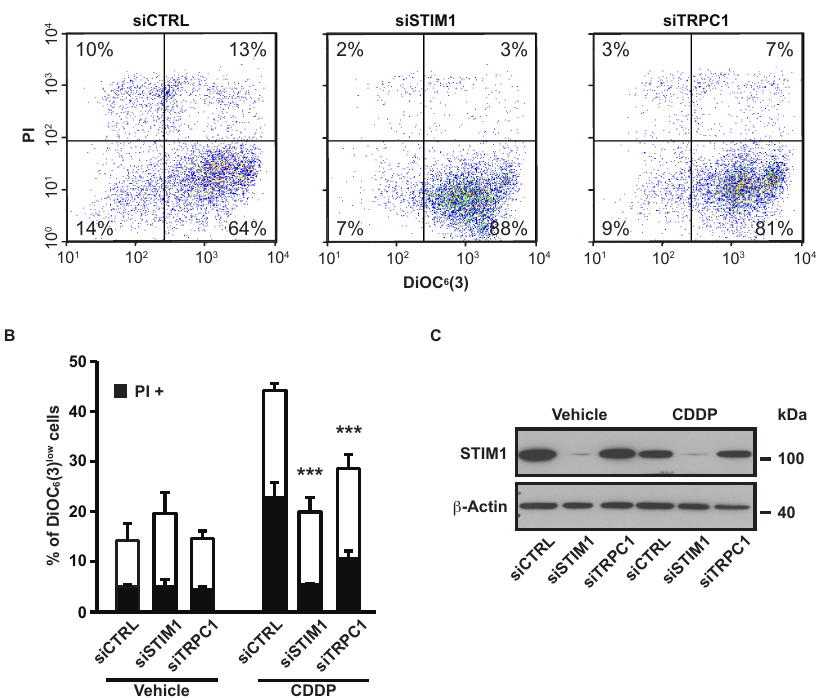
Figure 2. Effects of STIM1 and TRPC1 depletion on apoptosis-associated mitochondrial transmembrane potential ( ∆Ψ m ) dissipation and plasma membrane permeabilization. ( A ) Following transient transfection (for 72 h) with either siRNA downregulating STIM1 (siSTIM1) or TRPC1 (siTRPC1) or with a control siRNA (siCTRL), A549 cells were left untreated or treated for additional 24 h with 25 µ M CDDP, and labeled for the cytofluorometric assessment of ∆Ψ m (with the ∆Ψ m -sensitive probe DiOC 6 (3)) and plasma membrane integrity (with propidium iodide, i.e., PI). ( B ) Quantification of data presented in A. White and grey columns represent the percentage of cells exhibiting ∆Ψ m loss alone (DiOC 6 (3) low ) or in association with plasma membrane breakdown (PI + ), respectively. Data are means of triplicate experiments ± S.D. and are representative of three independent experiments. Student’s t test was employed to assess statistical significance. *** p < 0.001. ( C ) Immunoblot analysis of STIM1 expression 96 h after transfection of A549 cells with siCTRL, siSTIM1 or siTRPC1. β -actin was used as loading control.